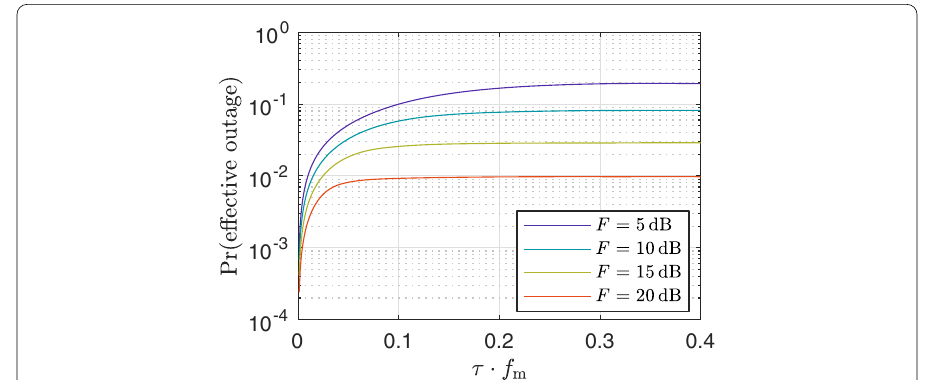
Fig. 1 Performance of outage identification, when relying purely on the latest channel